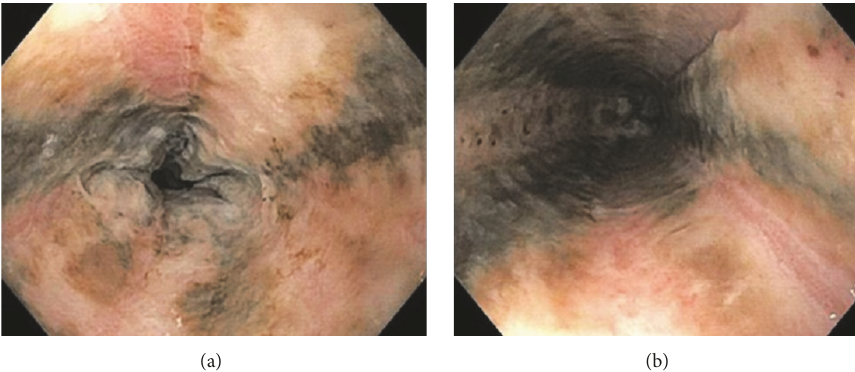
Figure 2: EGD image showing longitudinal ulceration and necrosis of the distal esophagus. Image (a) is slightly more distal and shows the significant mucosal necrosis and erosion. Image (b) shows the diffusely black appearance secondary to the ischemic